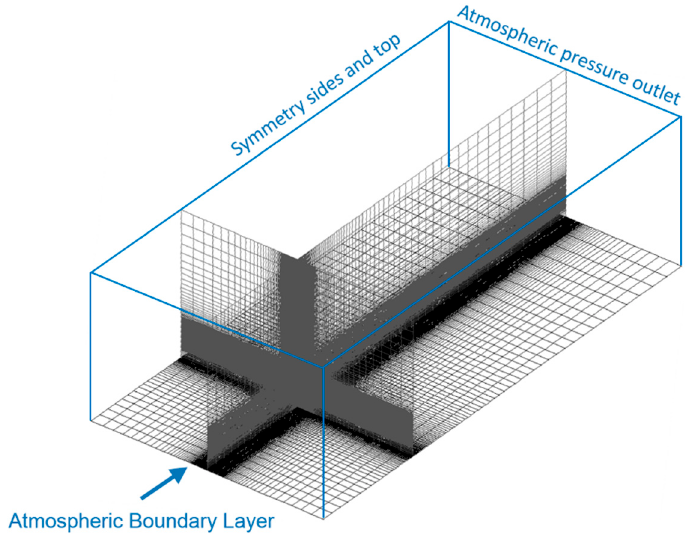
Figure 1. Overview and sections of the CFD computational domain of the background for the ABL with indications of the used boundary conditions.